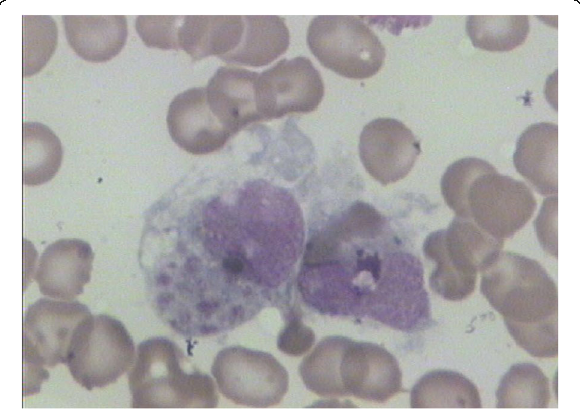
Fig. 1 The bone marrow examination. Phagocytosis was clearly observed without any evidence of